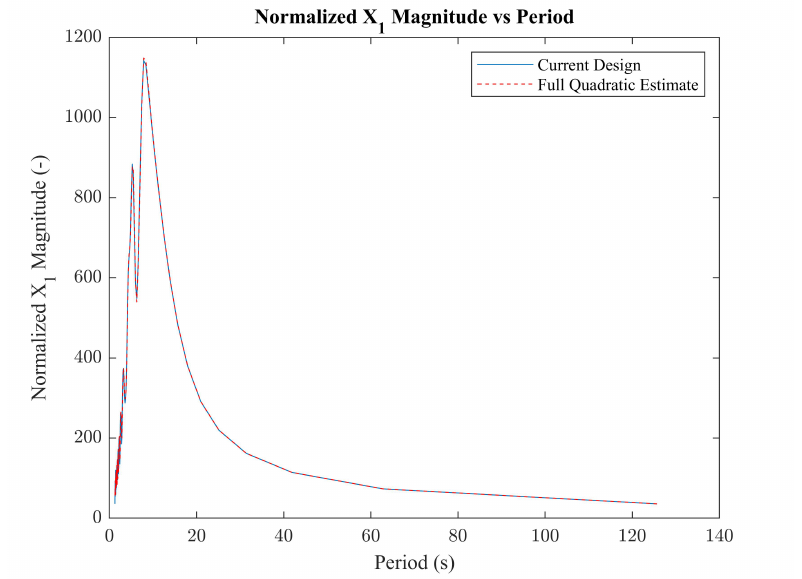
Figure 11. A graph comparing the X 1 values in terms of period from WAMIT with the polynomial